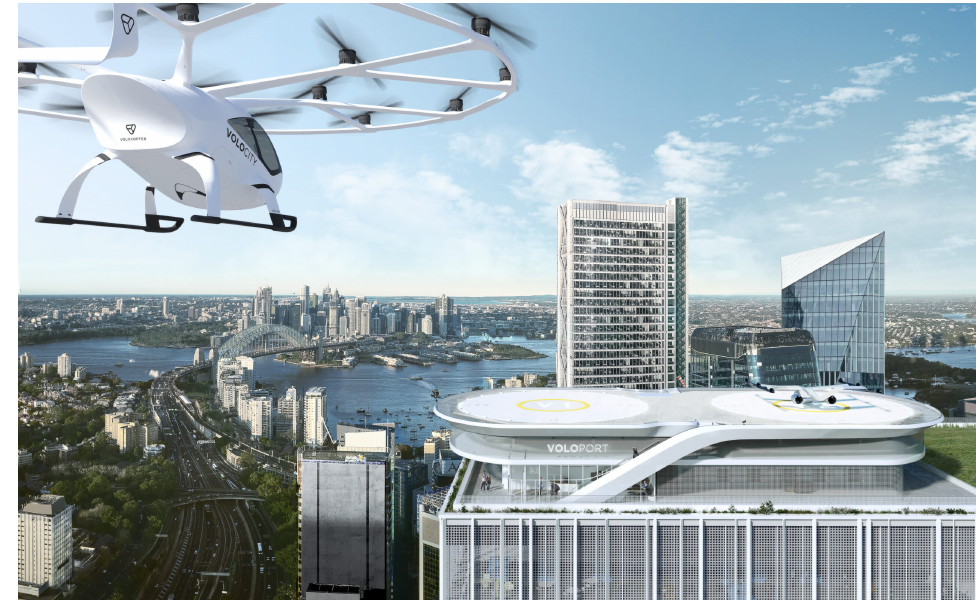
Figure 5. VoloPort vertiport concept by Volocopter, designed for urban eVTOL operations. Image credit: Volocopter